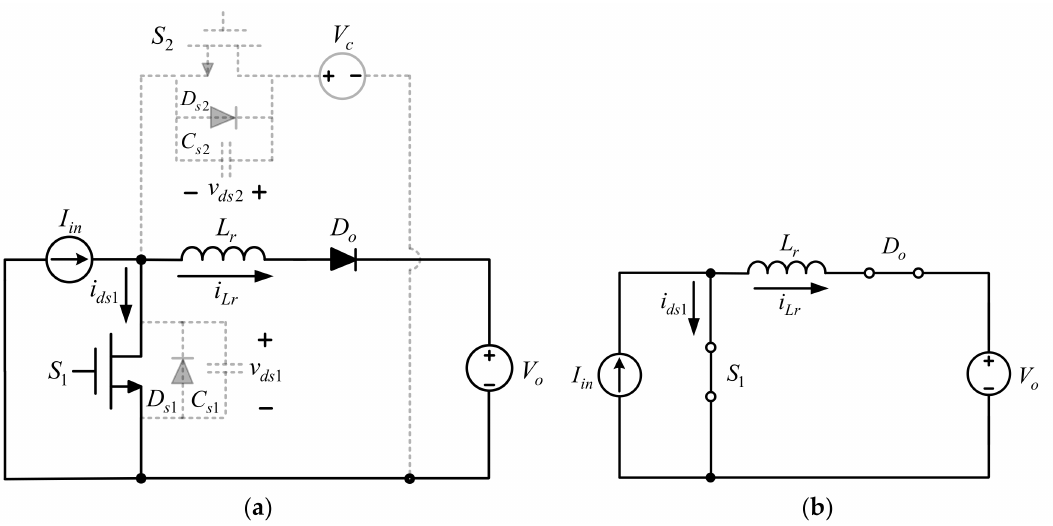
Figure 11. ( a ) Current path for stage 8; ( b ) equivalent of ( a